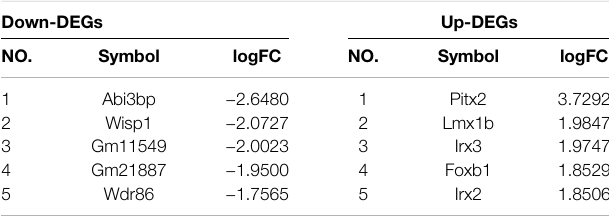
TABLE 2 | Top fi ve DEGs with log2 (fold change) among the overlapping signi fi cant DEGs. Down-DEGs Up-DEGs NO.